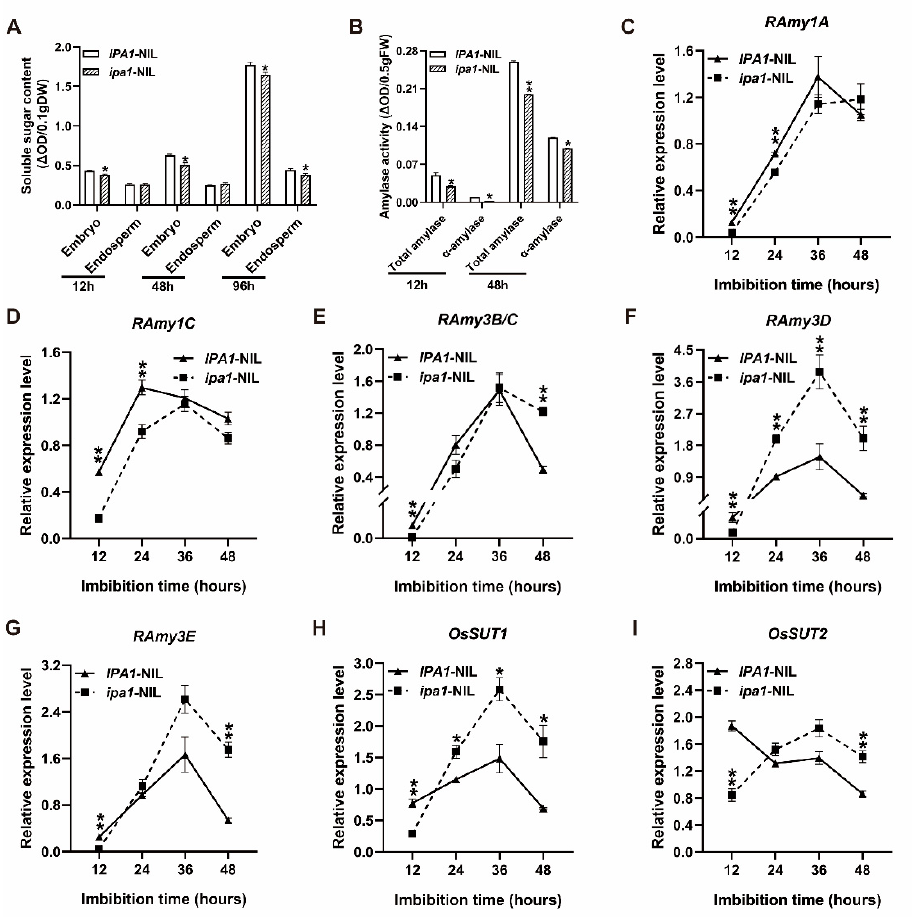
Figure 2. The impacts of IPA1 on starch metabolism during germination and early seedling growth. ( A ) The soluble sugar content of NILs in the embryo and endosperm at different time points. ( B ) The amylase activity in NILs. ( C – G ) The relative expression level of α -amylase genes RAmy1A ( C ), RAmy1C ( D ), RAmy3B/C ( E ), RAmy3D ( F ), and RAmy3E ( G ). ( H , I ) The relative expression level of sugar transport-related genes OsSUT1 ( H ) and OsSUT2 ( I ). Significant differences were determined using Student’s t -test (* p < 0.05, ** p < 0.01).